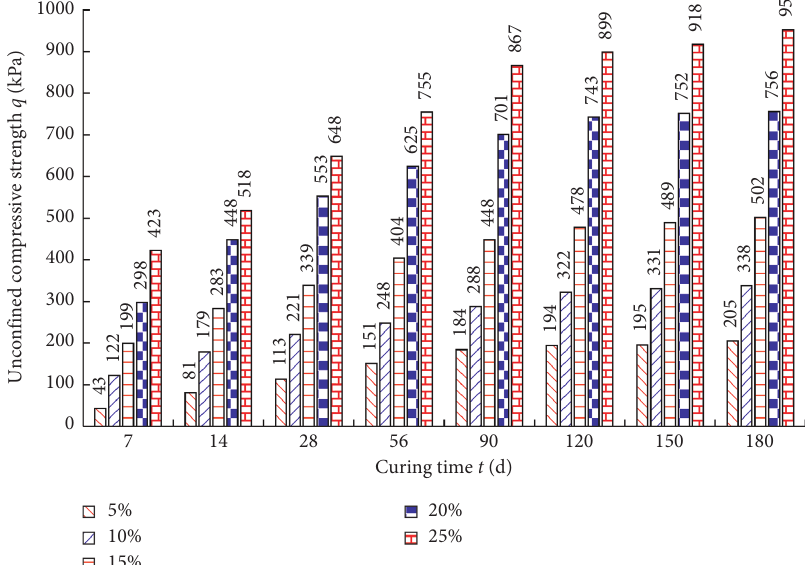
Figure 7: The UCS of the CMS with different cement contents at different curing ages.